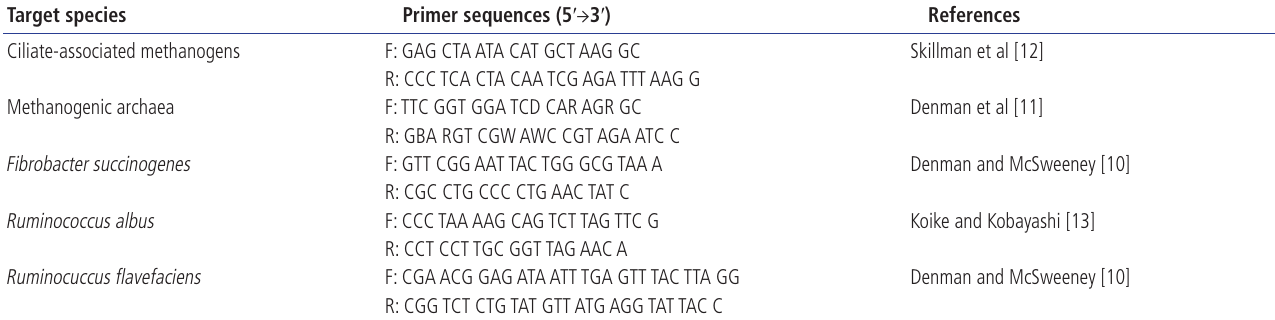
Table 1. Polymerase chain reaction primer sets for real-time polymerase chain reaction assays Target